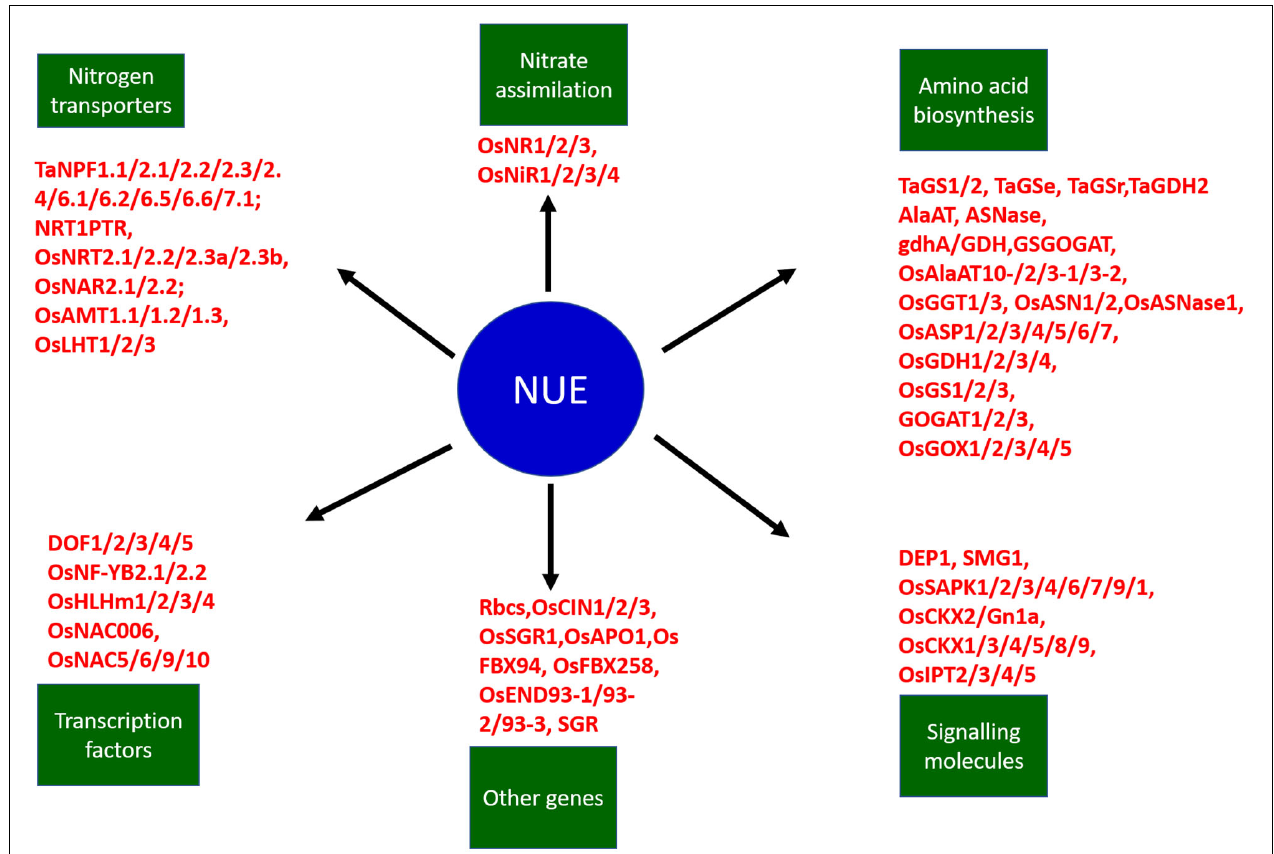
FIGURE 6 | The schematic representation of the network of nitrogen transporters, genes, transcription factors, and signaling molecules involved in nitrogen use efficiency in cereal crops such as wheat and rice. NUE improvement involves multiple interconnected factors such as transporters, signal molecules, amino acid biosynthesis, nitrate assimilation, transcription factors, and other genes. The transporters and nitrate assimilation genes are particularly involved in nitrogen uptake, amino acid biosynthesis genes are involved in nitrogen utilization, and the signaling molecules, transcription factors, and other genes have passive roles in both nitrogen uptake and nitrogen utilization. Ta represents Triticum aestivum and Os represents Oryza